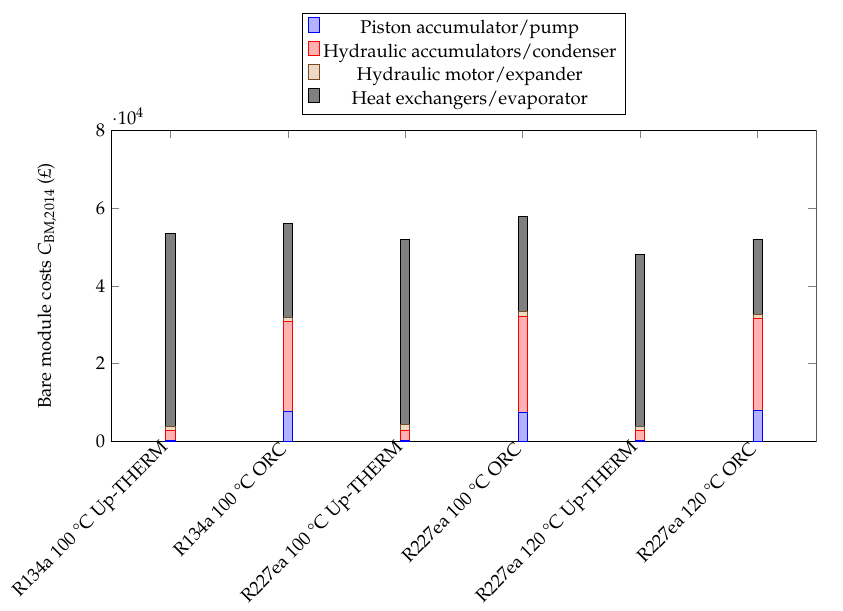
Figure 11. Bare module costs for the Up-THERM heat converter and equivalent ORC engines for the refrigerants R134a and R227ea as working fluids at different heat-source temperatures.